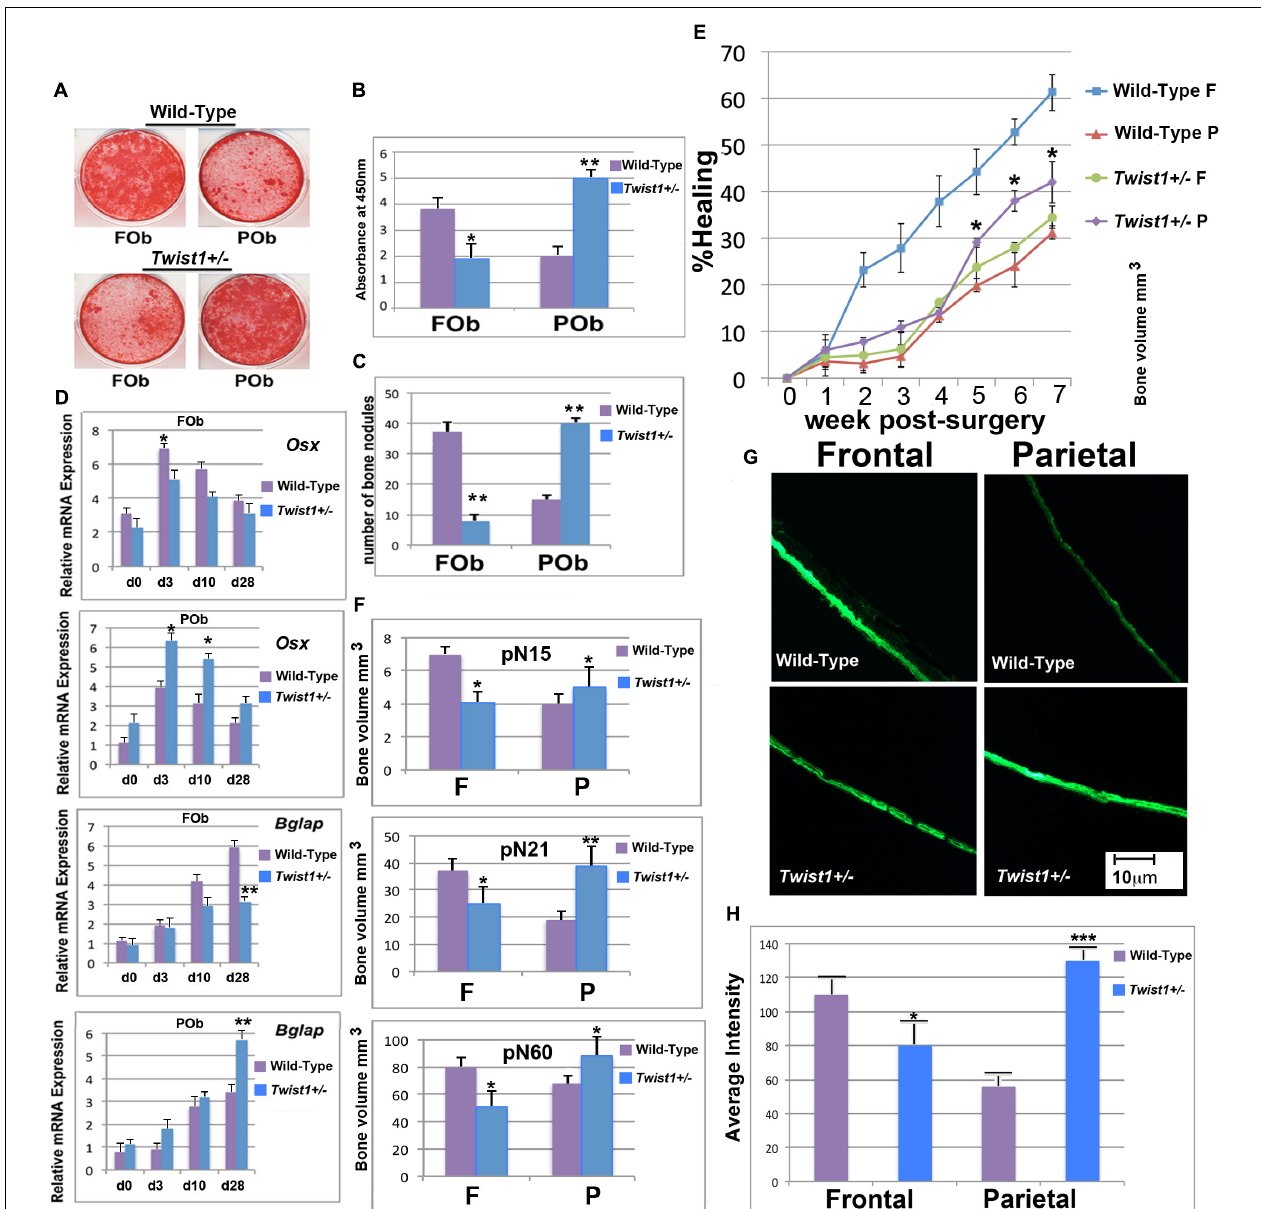
FIGURE 2 | Twist1 haploinsufficiency enhances the osteoskeletal potential of mesoderm-derived parietal bone. (A) FOb and POb cultured under osteogenic conditions for 28 days and stained with Alizarin Red. (B) Quantification of Alizarin Red staining revealing a more intense mineralization of the extracellular matrix in Twist1 + / − POb as compared to wild-type POb. (C) Number of large bone nodules formation identified by von-Kossa staining at osteogenic differentiation day 28. (D) Relative mRNA expression of early ( Osx ) and late ( Bglap ) osteogenic markers in wild-type and Twist1 + / − osteoblasts cultures. Results are representative of three experiments performed. (E) Time course of frontal and parietal bone healing defects, quantification of defect repair ( n ? = ?5/each bone) based on µ CT results are analyzed using magic wand tool in Photoshop after standardization of threshold for regenerating calvarial bone. Results are representative of two independent experiments performed. Statistical analysis was performed using the Mann–Whitney Test. ∗ P ≤ 0.05. (F) Quantification of bone thickness in uninjured wild type and Twist1 + / − Frontal and Parietal bones ∗ P ≤ 0.05. (G) Bone formation in wild-type and Twist1 + / − frontal and parietal bones assessed by culturing skulls for 48 h